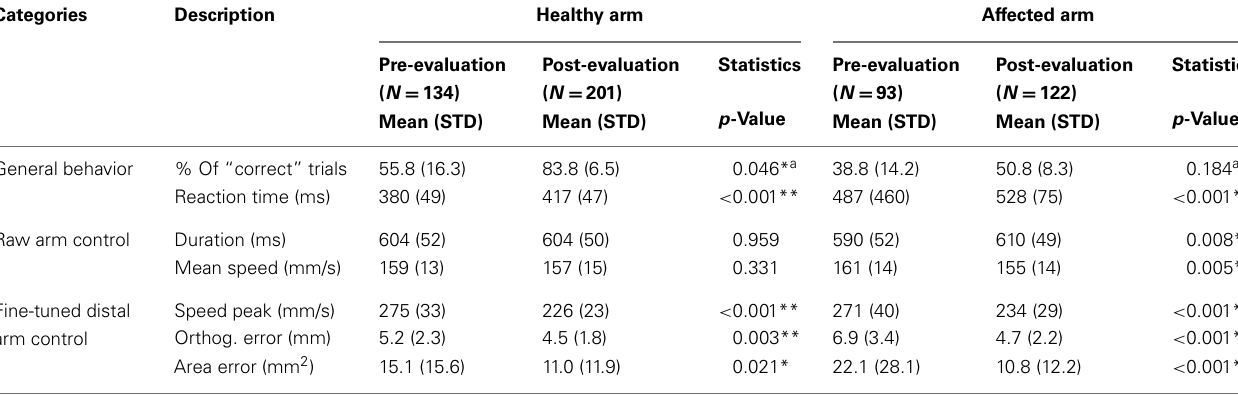
Table 1 | “Correct” trials kinematic